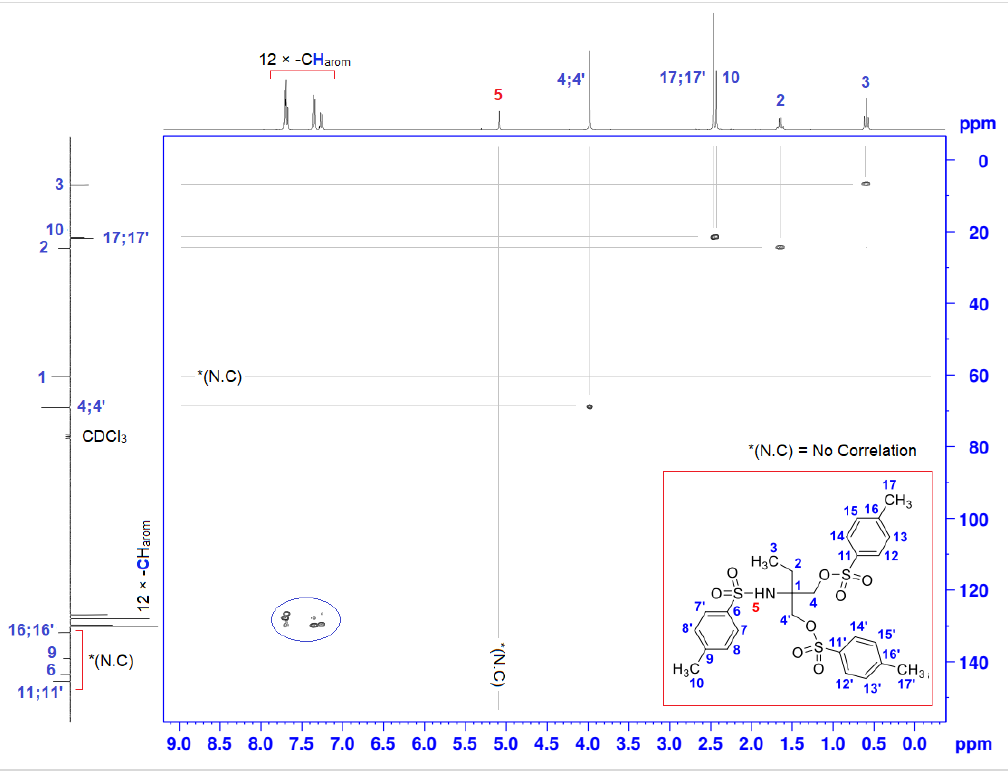
Figure 1. 2D HSQC spectrum of compound ( 2 ). “*”: No correlation. Table 2. 1 H (300 MHz) and 13 C (75 MHz) NMR spectral data for compound ( 3 ) in CDCl 3 , including results obtained by homonuclear 2D-shift-correlated and heteronuclear 2D-shift-correlated HMBC. Chemical shifts (δ in ppm) and coupling constants ( J in Hz).